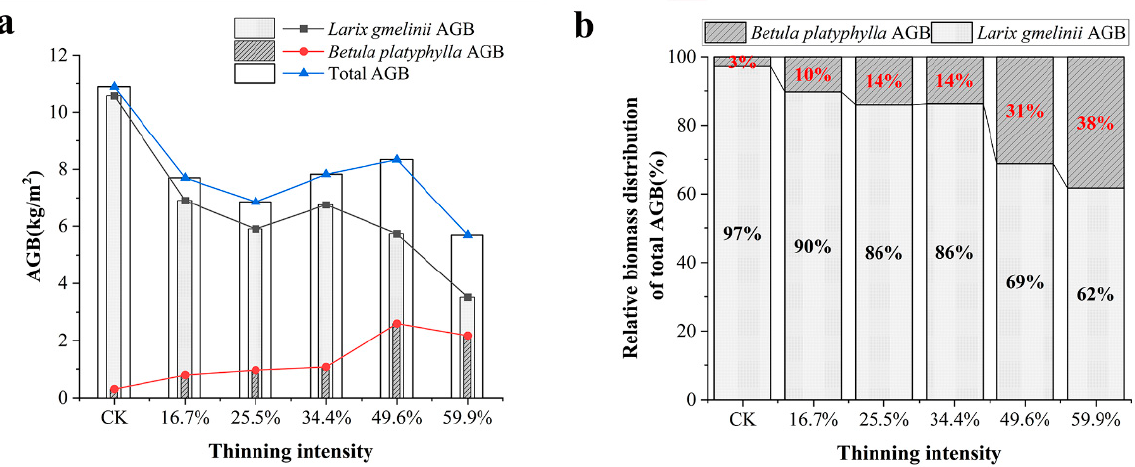
Figure 6. AGB of tree layer under different thinning intensities. Note: ( a ) shows the total AGB of larch, birch and stand in the tree layer, ( b ) is the relative distribution of total AGB of Larch and birch in the tree layer.